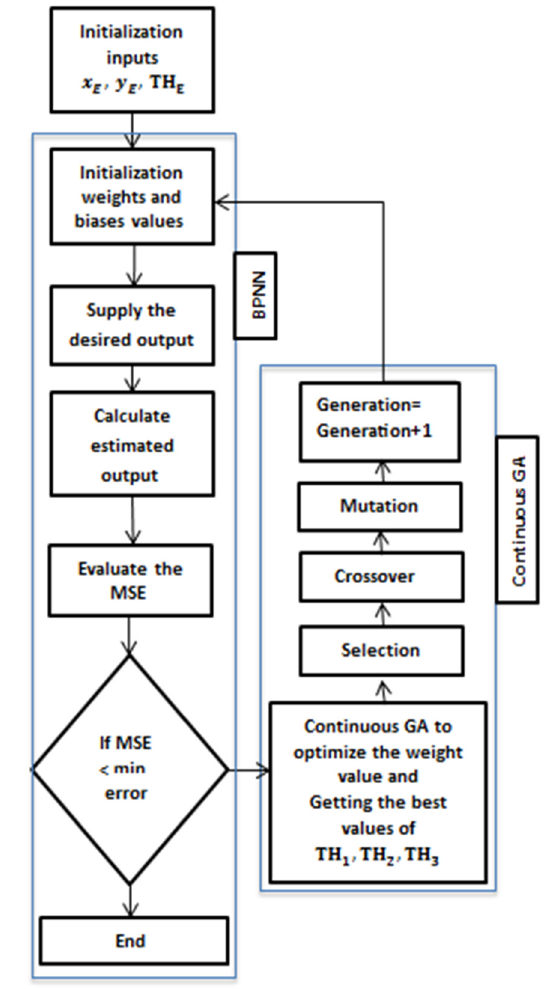
Fig. 6. Flowchart of BPNN optimization by